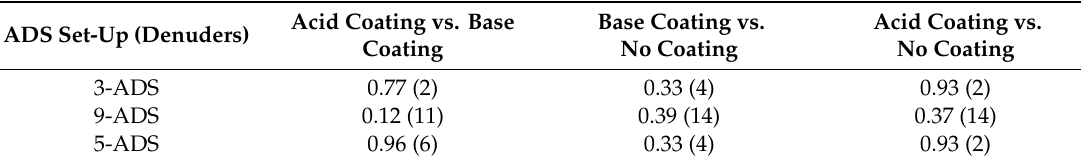
Table 4. Statistical Analysis of Coating Treatment per ADS Set-Up alternatives. The p -values for the t -tests comparing the mean values of percent concentrations on denuder surfaces between coating treatment types with unequal variances and a 95% confidence interval. The degrees of freedom are shown in brackets.